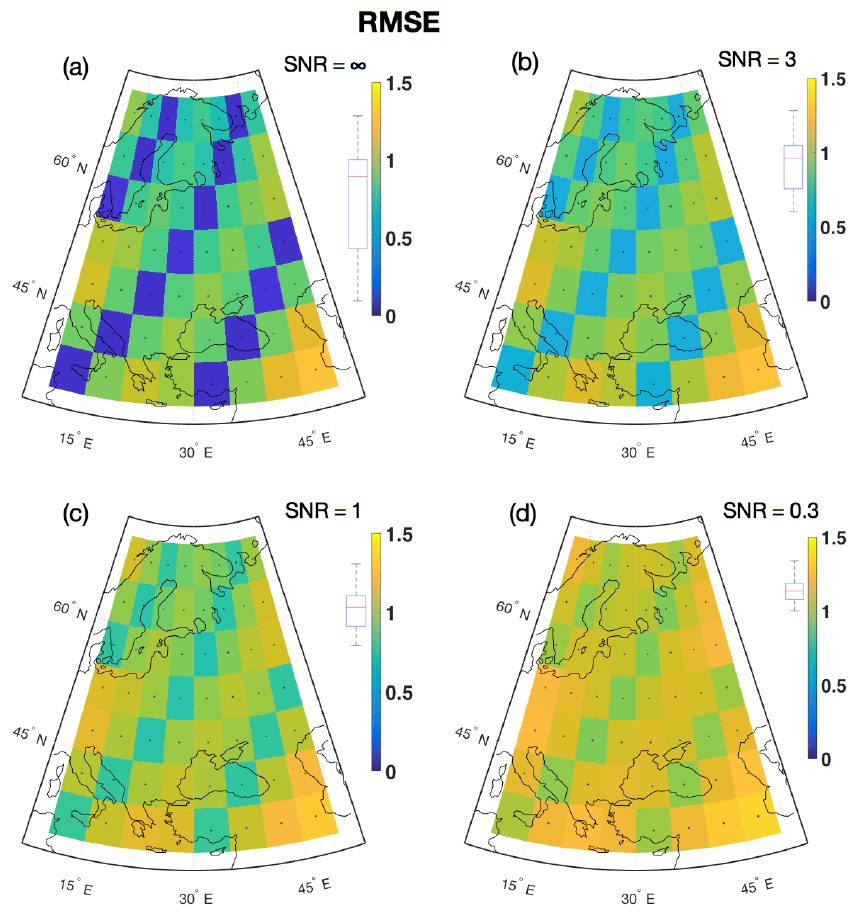
Figure 8. Local RMSE between reconstructed temperature field and target field for the verification period. The box plots left of the color bars indicate the distribution of grid point correlation coefficients. β =